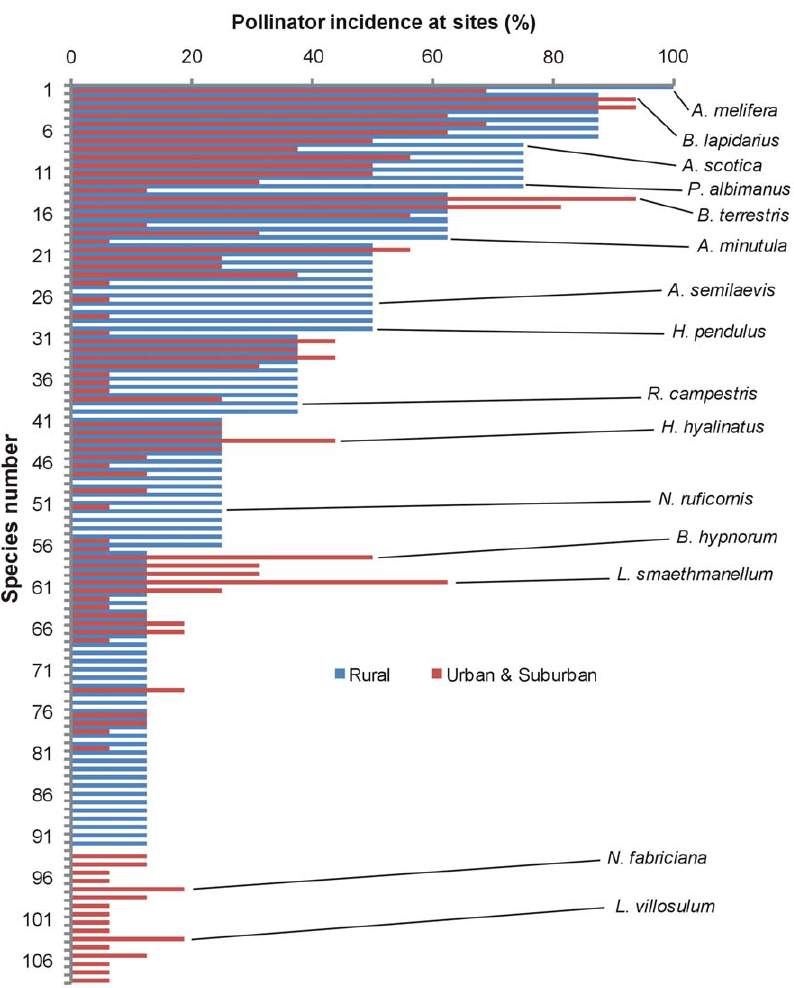
Figure 6. Species incidences of all species at rural, and urban and suburban combined. Data for urban and suburban sites were combined for clarity as they were very similar. Certain species are highlighted, but patterns for all species can be found using the species number in Table S1.